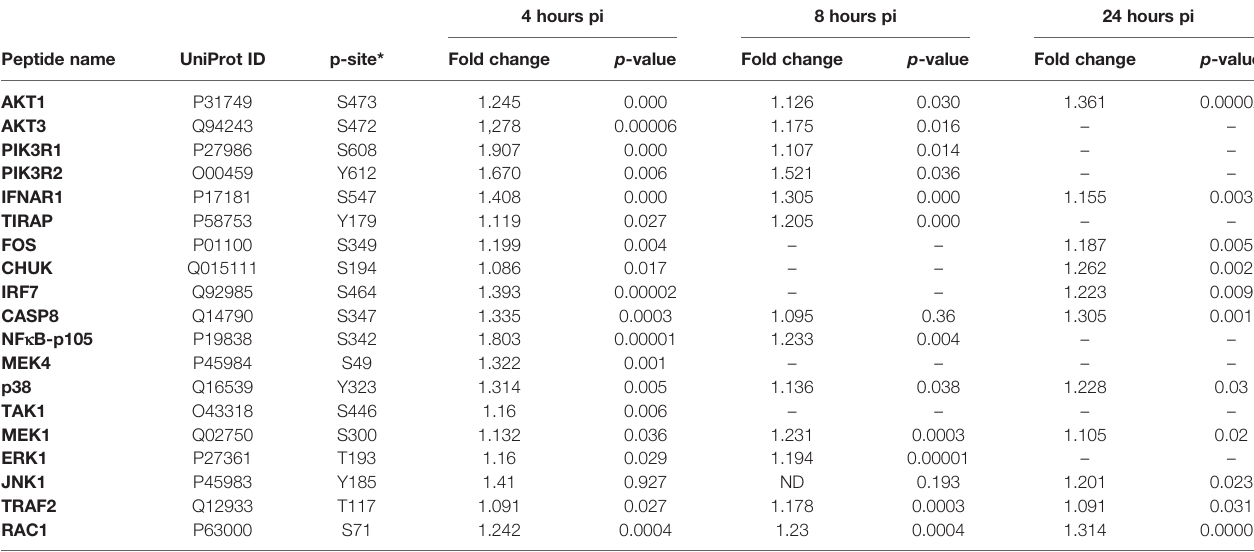
TABLE 4 | Members of the TLR signaling pathway showing differential phosphorylation between Salmonella enterica serovar Enteritidis-infected cecal tissue and non- infected cecal tissue.